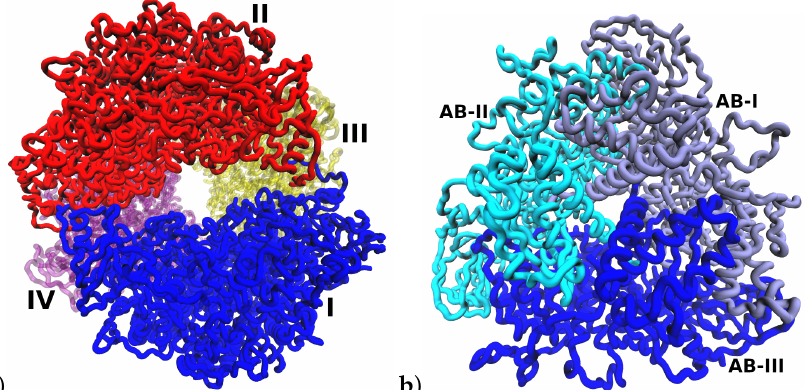
Figure 4. Representation of urease at pH 2. ( a ) (( αβ ) 3 ) 4 multimeric structure. Each ( αβ ) 3 is shown in a different color and indicated with I, II, III and IV. The separation of cluster I and cluster II increases at pH 2. ( b ) Similar structural arrangement for the ( αβ ) 3 subunit.